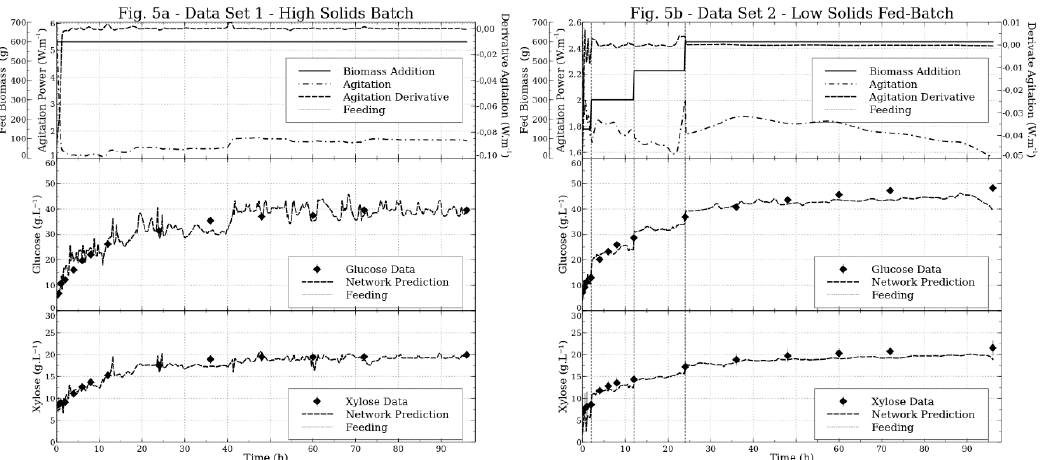
Figure 5. Carbohydrates concentration prediction for optimum Artificial Neural Network (ANN) using the training data sets. ( a ) High Solid Batch (HSB) predictions; and, ( b ) Low Solids Fed-batch (LSB) predictions; top graphs are input variables to the network for each data set, middle and bottom graphs are glucose and xylose predictions; error bars in data points are standard errors between experiment duplicates for compound concentration; vertical dotted lines are the biomass feeding times.